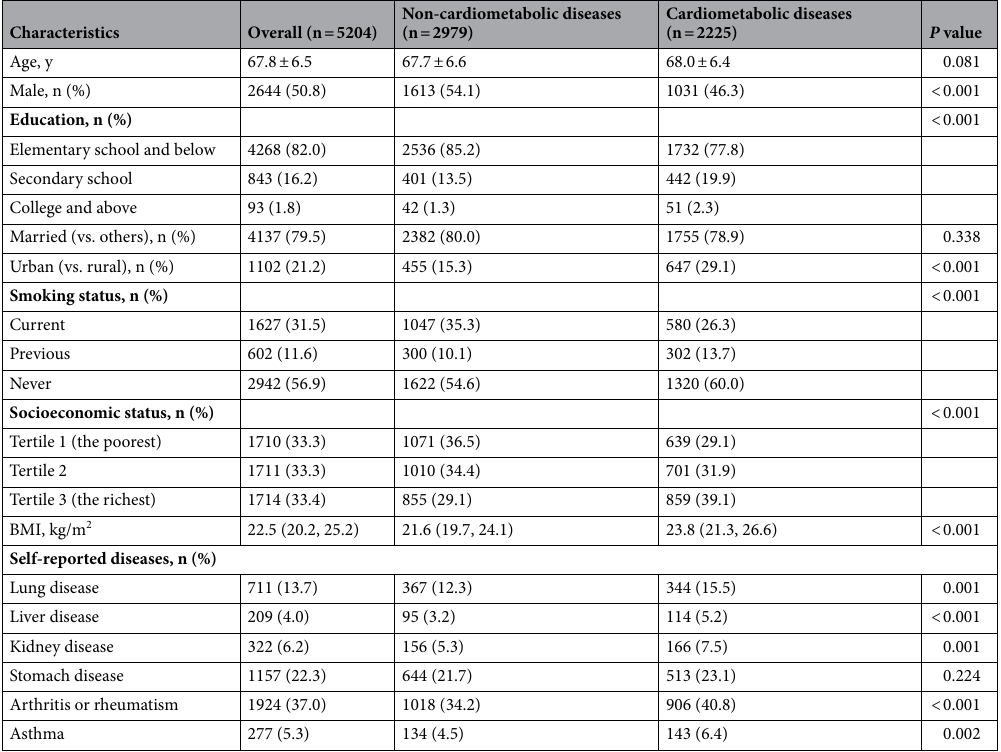
Table 1. Baseline characteristics of participants according to cardiometabolic diseases status. Data are shown as means ± standard deviation, median (interquartile range), or numbers